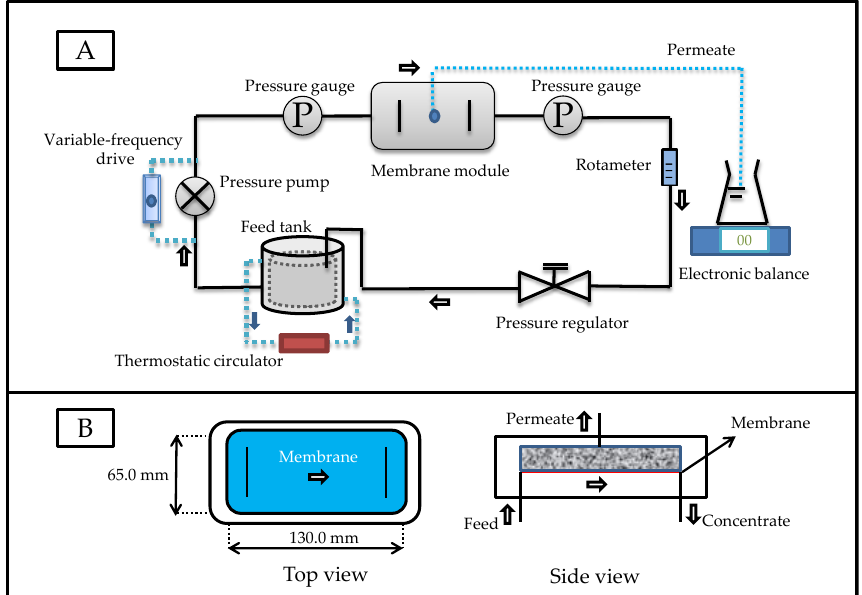
Figure 1. Flow charts of: ( A ) t he flat-plate crossflow filtration device; ( B ) the membrane module.